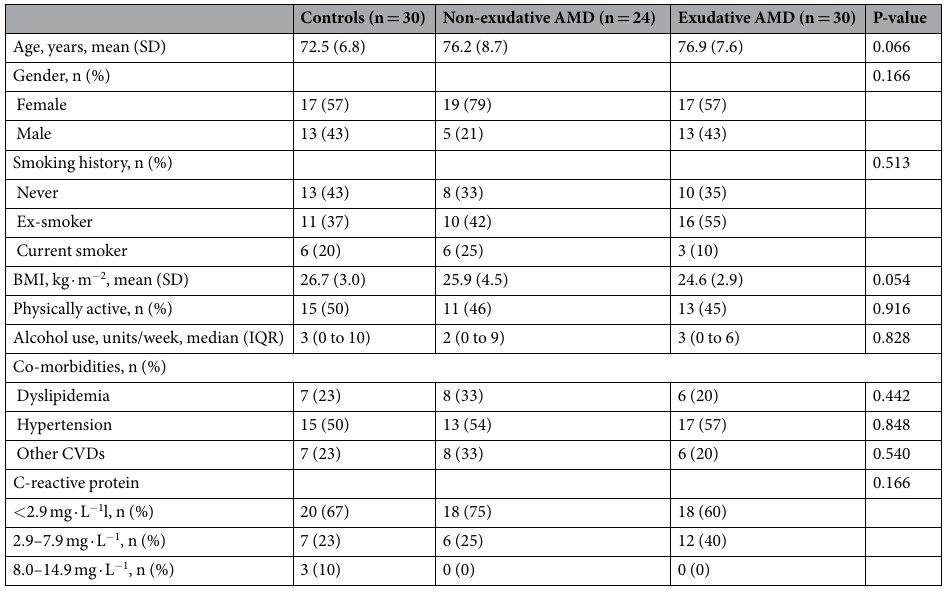
Table 1. Demographic, lifestyle, and medical characteristics of included study participants. Abbreviations: n = number; AMD = age-related macular degeneration; SD = standard deviation; BMI = body mass index; CVDs = cardiovascular diseases. Missing data: smoking history is missing for one participant with exudative AMD, body mass index is missing for two participants with non-exudative AMD, and physical activity is missing for one participant with exudative AMD. P-values are calculated using analysis of variance (ANOVA) for age and body mass index; Kruskal-Wallis’ test for alcohol consumption, χ 2 -test for hypertension and physical activity; and Fisher’s Exact test for gender, smoking, dyslipidemia, other cardiovascular conditions, and C-reactive protein levels.